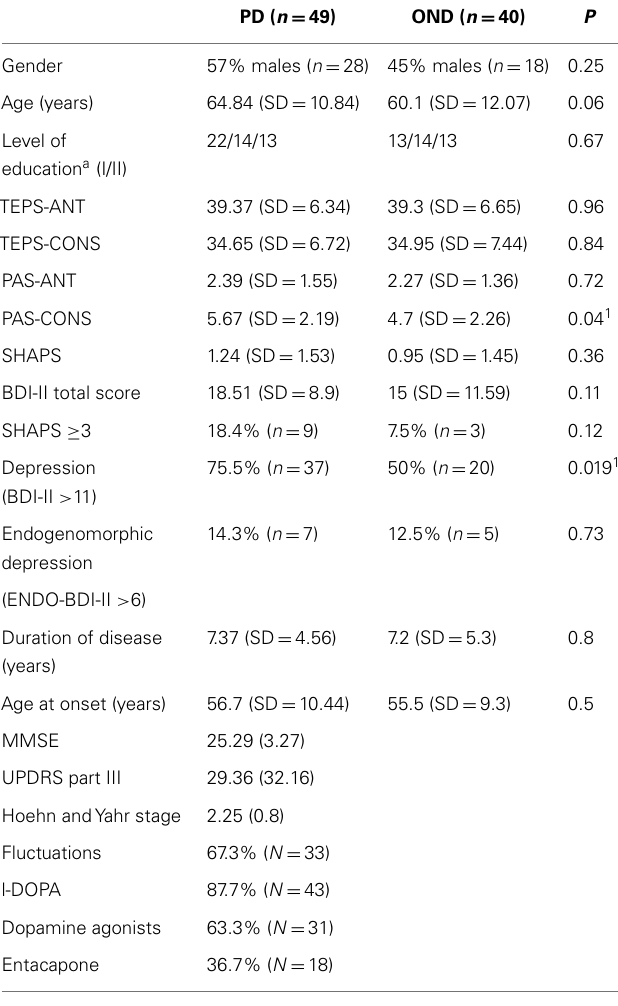
Table 1 | Comparison between Parkinson’s disease (PD) subjects and subjects with other neurologic disease (OND)